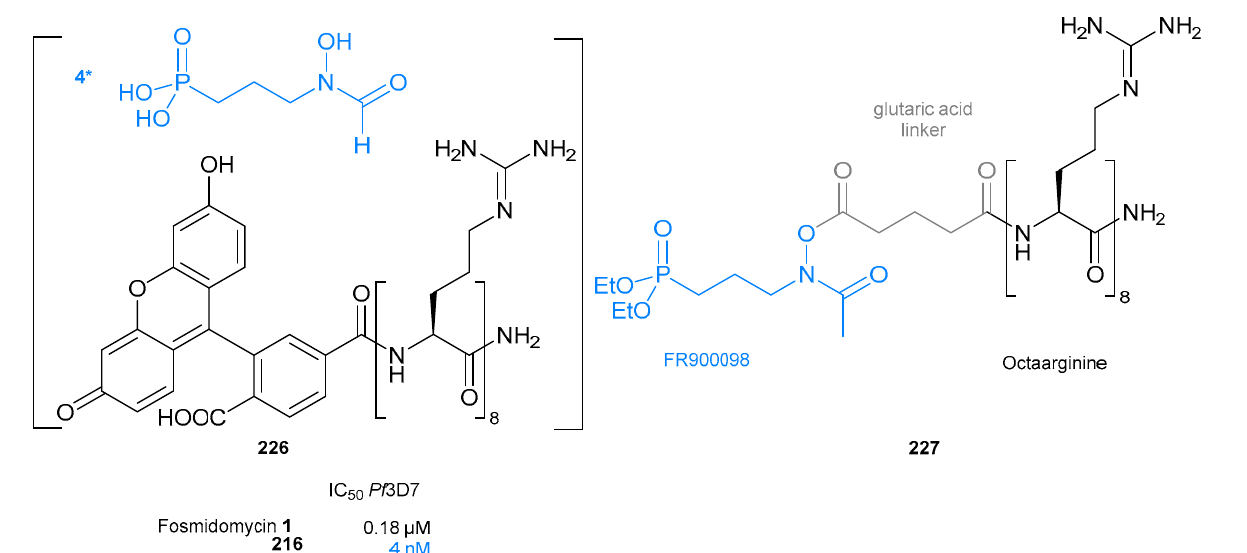
Figure 43. Structure and antiplasmodial activity of fosmidomycin ( 226 ) and FR900098 ( 227 ) octaarginine conjugates.